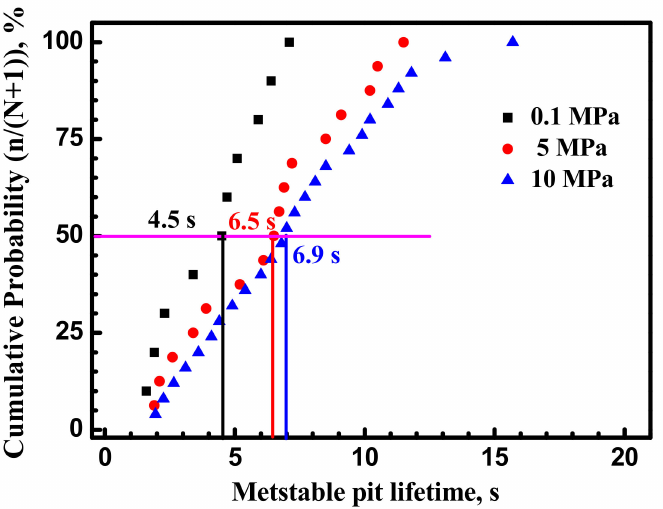
Figure 6. Cumulative distribution of metastable pits lifetime for the X70 steel at various hydrostatic pressures and − 100 mV vs. Ag/AgCl electrode.